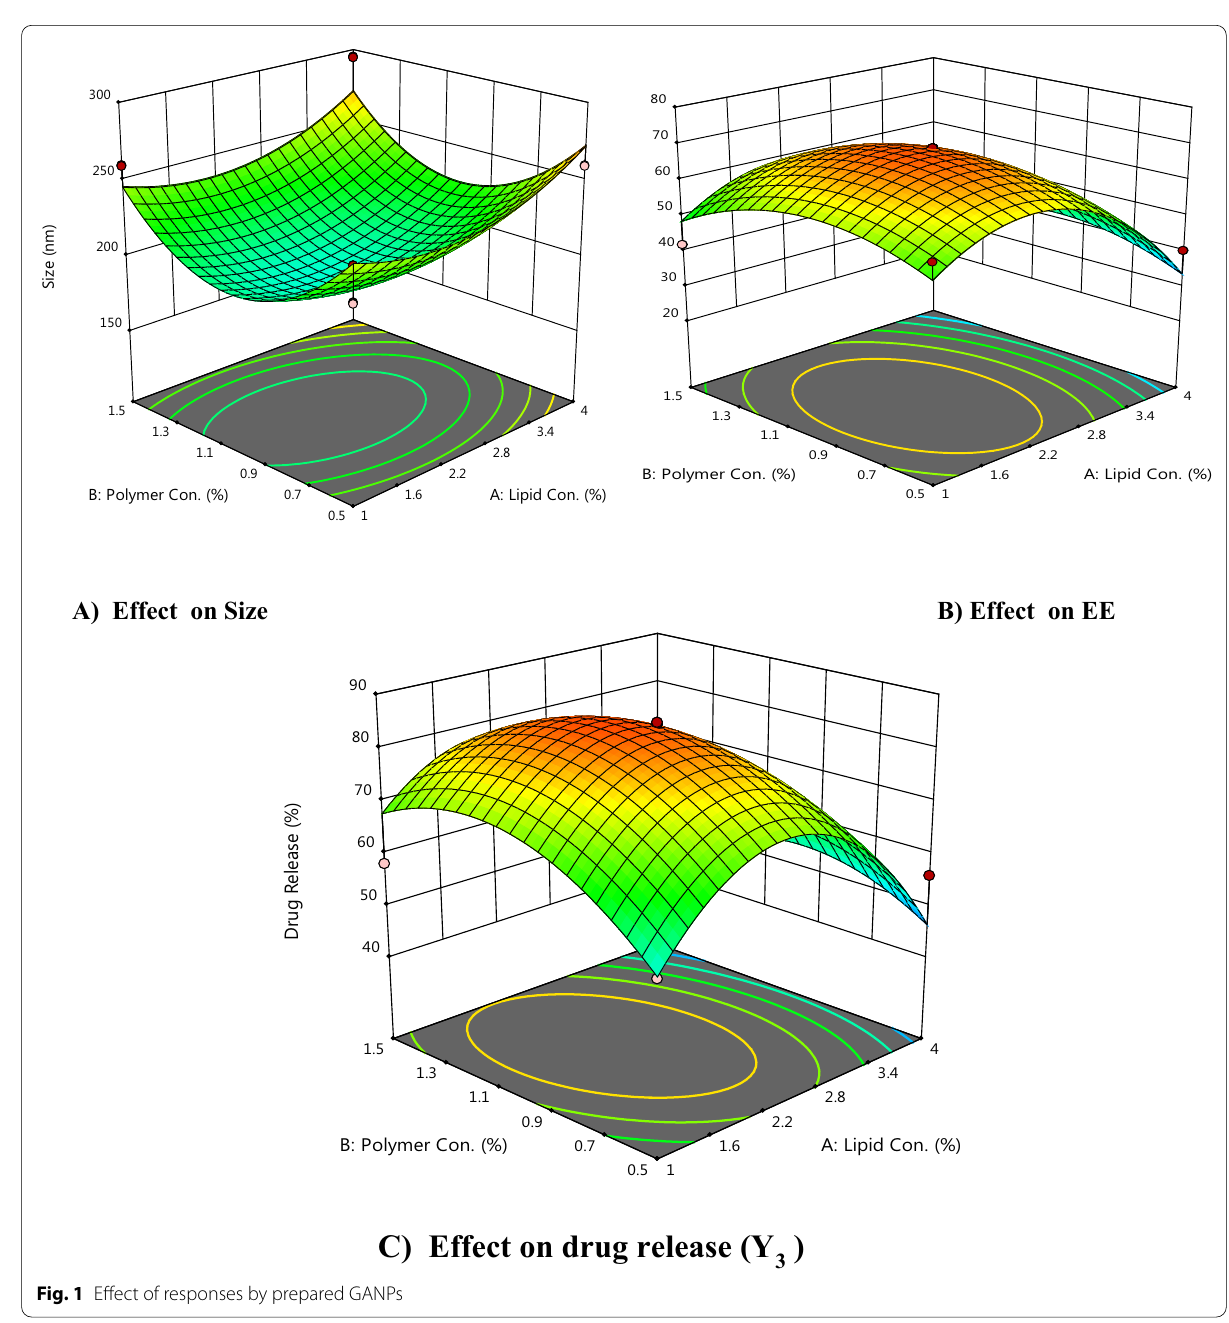
duplicate measurements were taken. The results are shown in Fig. 4. Differential scanning calorimetry (DSC): The sample (approx. 2 mg) was sealed in a crimped aluminium cell and heated at a speed of 10 °C/min from 50 to 300 °C in an atmosphere of nitrogen. And finally, the data were recorded. The results are shown in Fig. 3.